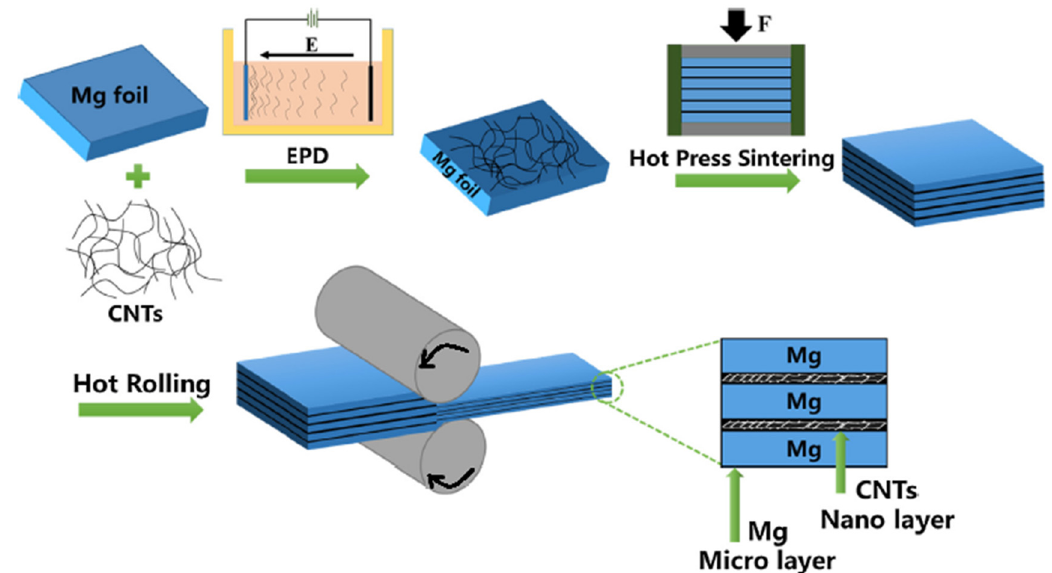
Figure 6. Schematic illustration of fabricating a micro-nano layered structure of Mg/CNTs composites